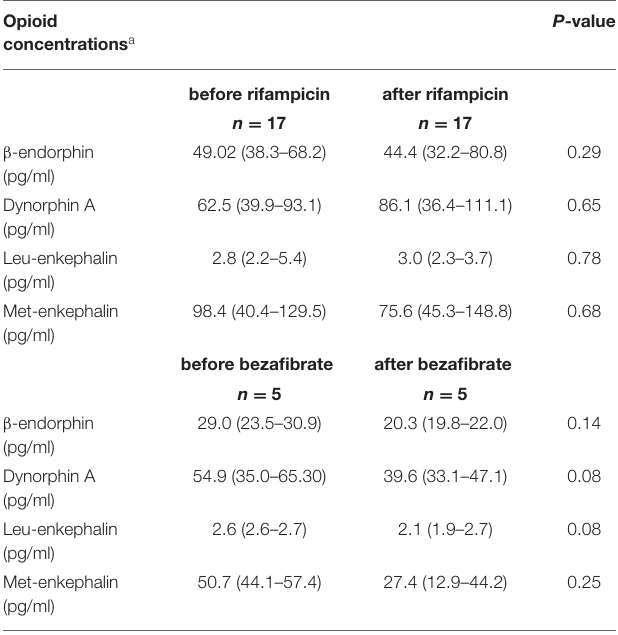
TABLE 3 | Endogenous opioid concentrations in 22 patients before and after receiving anti-pruritic treatment with rifampicin (150–300mg qd) or bezafibrate (400mg